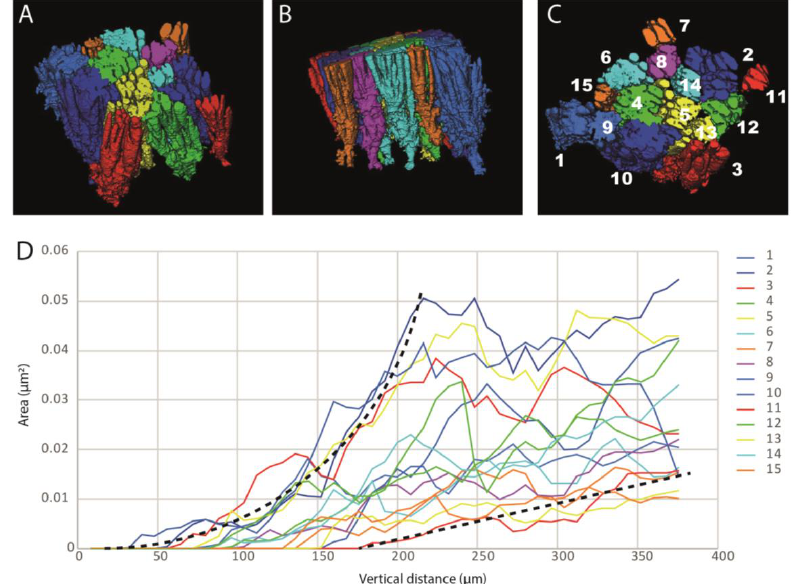
Figure 7. Maps showing the structure of 16 individual pillar growths in sample 83-21 B from three different views. The vertical scale is 0.4 mm. The pillars are much more complex than they appear in a two-dimensional (2D) view, with multiple, three-dimensional (3D) branching structures ( A ). This branching seems to occur at roughly the same time ( B ) and grow independently upwards and outwards, filling space ( C ). The graph ( D) shows how the cross-sectional area of the pillars changes upwards. Some samples seem to reach a maximum and then roughly maintain this area, while others grow more steadily, as indicated by the black dashed lines.